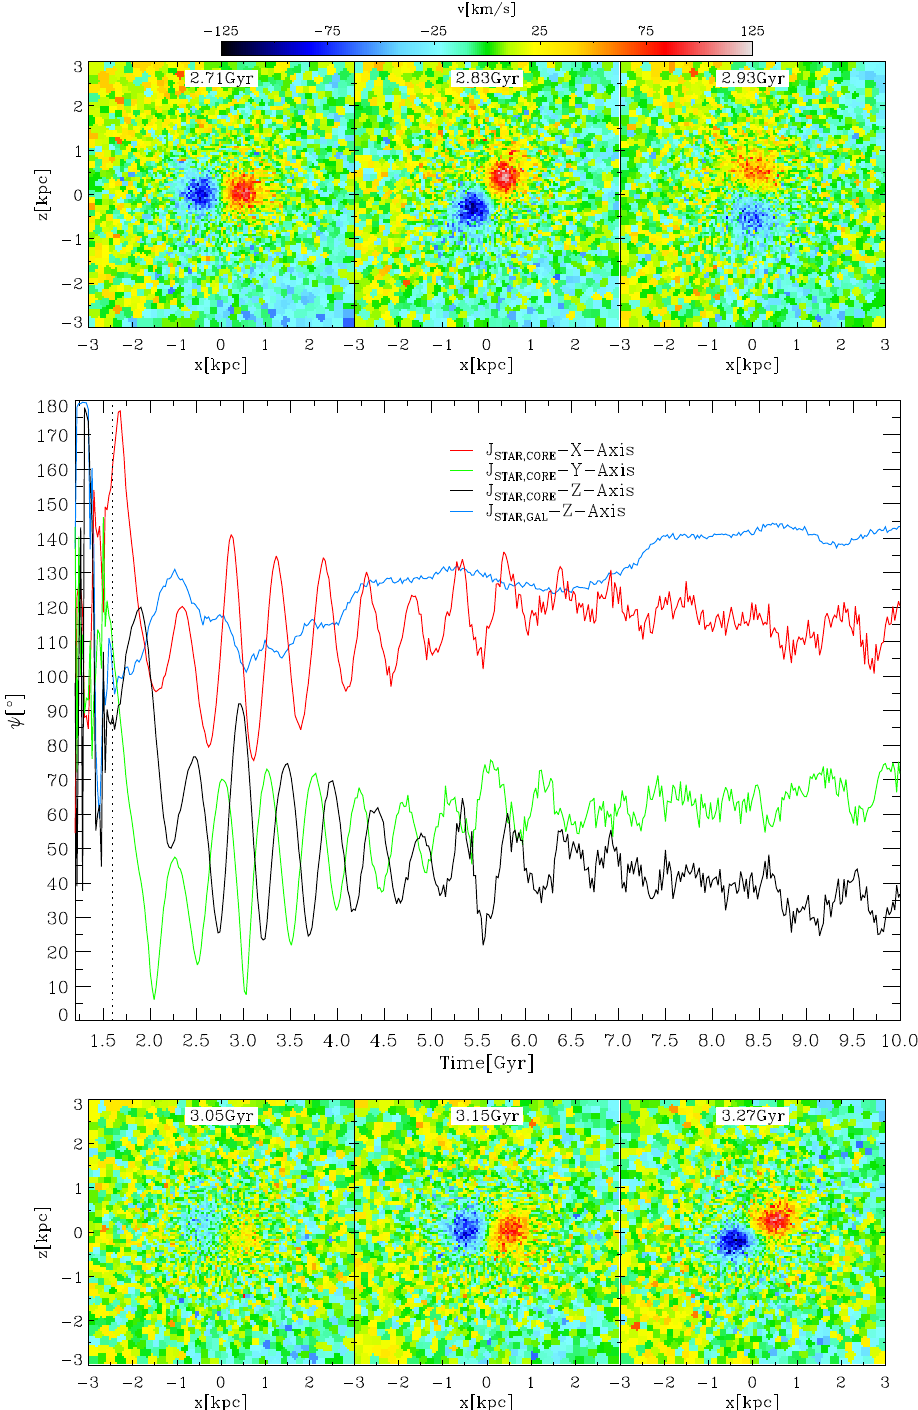
Figure 5. The main panel shows the temporal evolution of the angle between the total stellar angular momentum of the KDC and the three coordinate axes as given in the legend. The blue line for comparison shows the evolution of the angle between the angular momentum of the surrounding galaxy and the z -axis. The dashed vertical line marks the time at which the stellar mass accretion of the KDC is finished (see Figure 5). The upper and lower rows display a temporal sequence of the LOSVD map of the central 3 kpc in the x – z